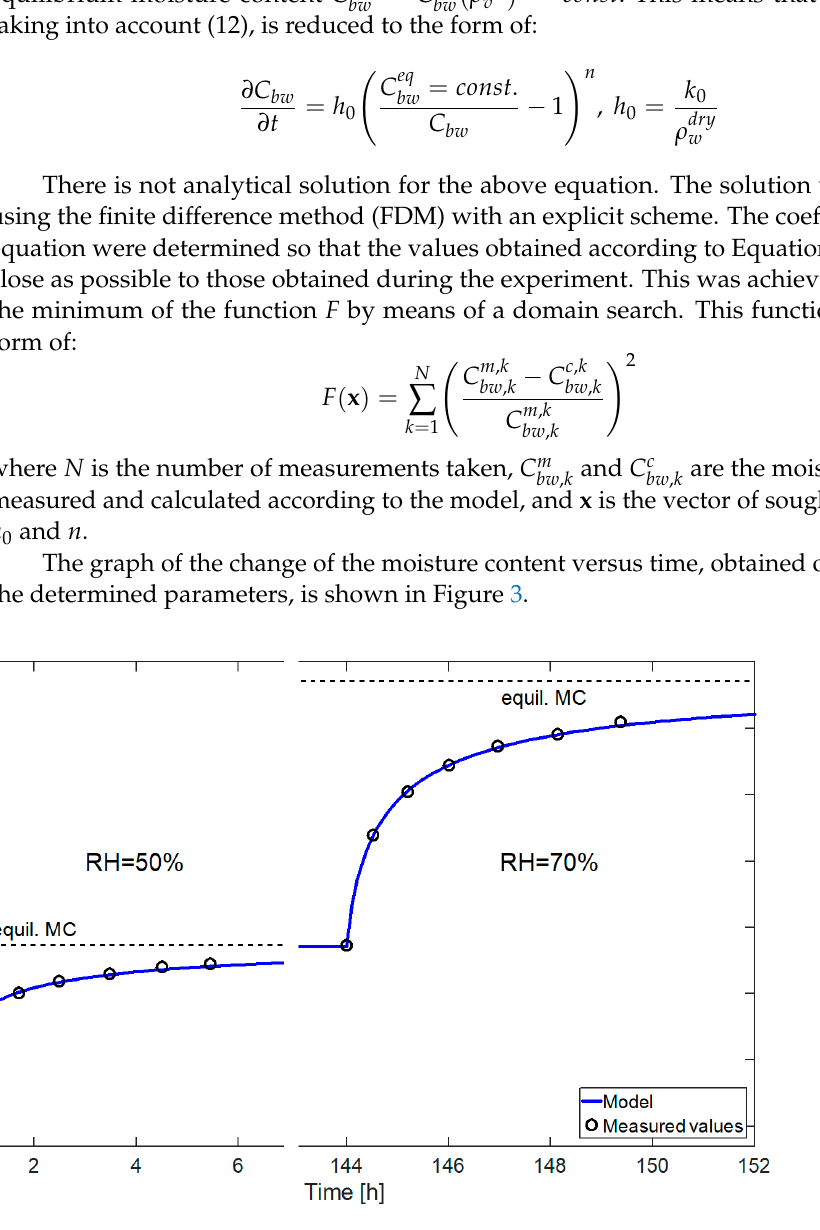
Figure 3. Change in moisture content in thin samples versus time.